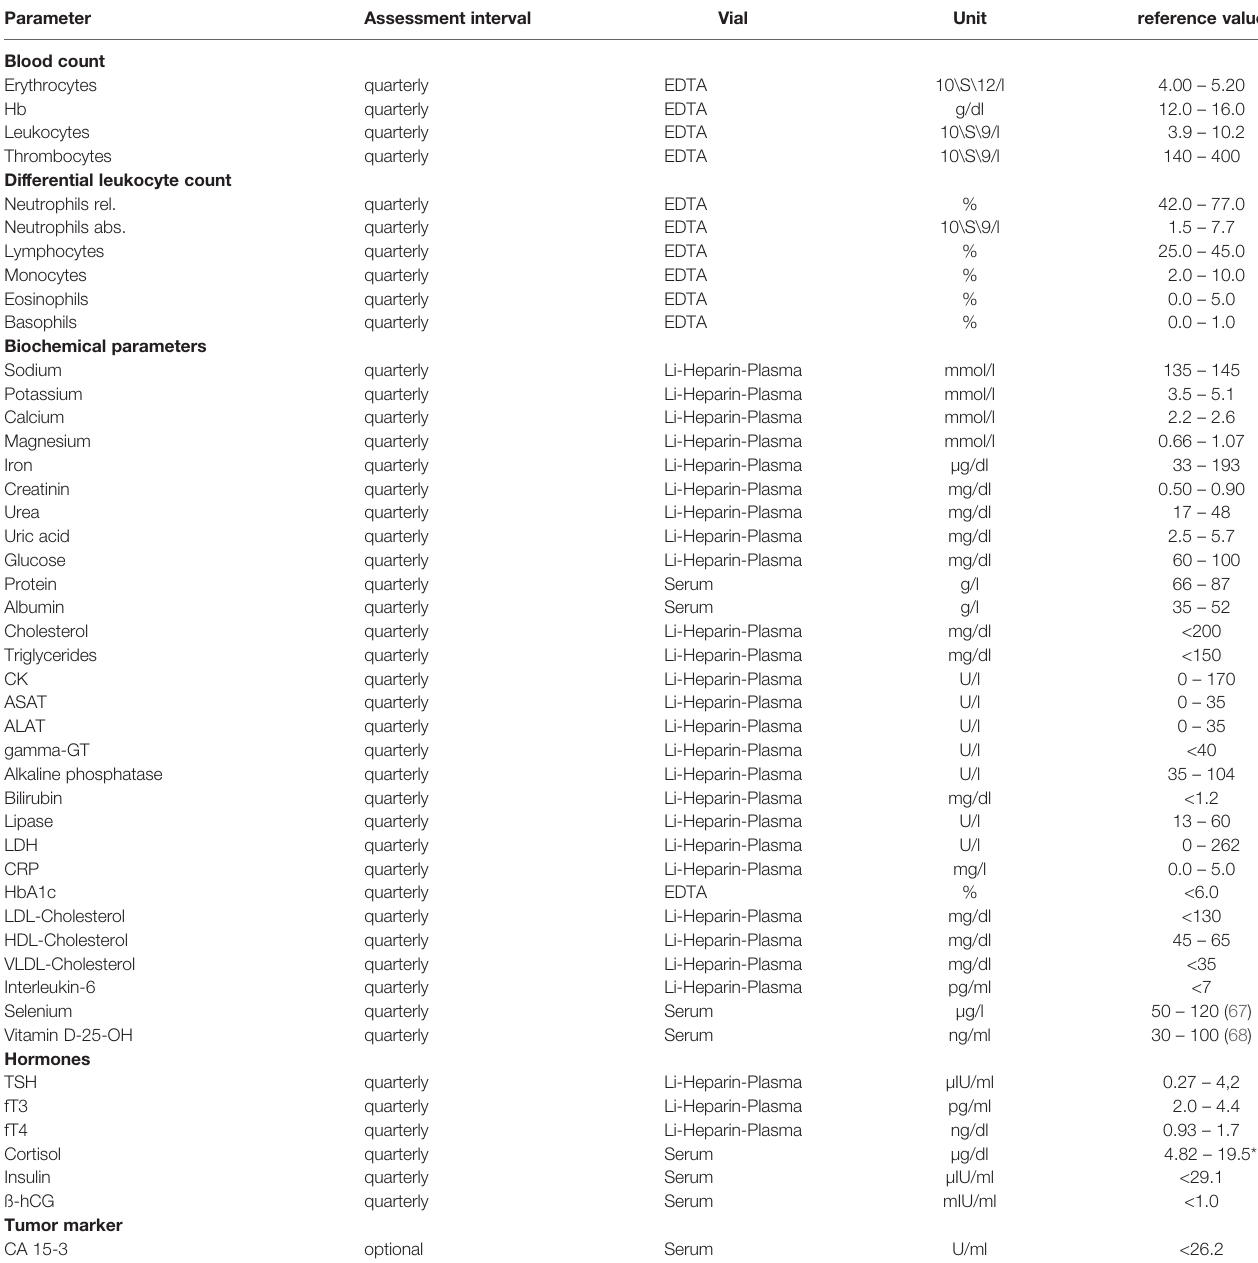
TABLE 5 | Laboratory values, intervals of assessment and reference